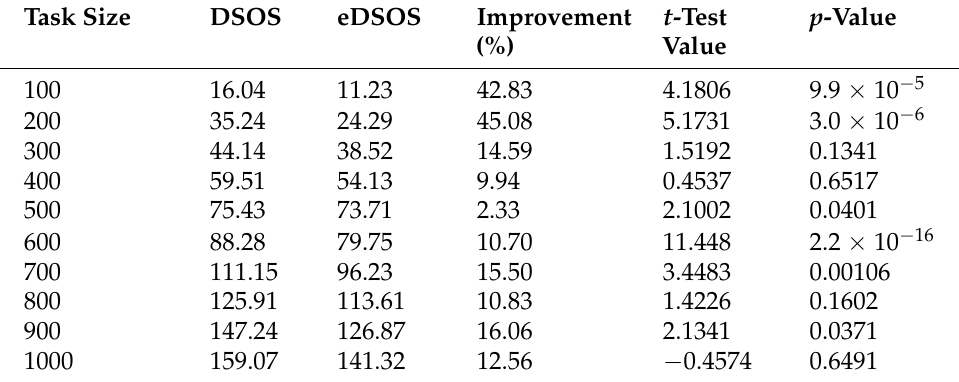
Table 9. Comparison of the response times of DSOS and eDSOS for the normally distributed